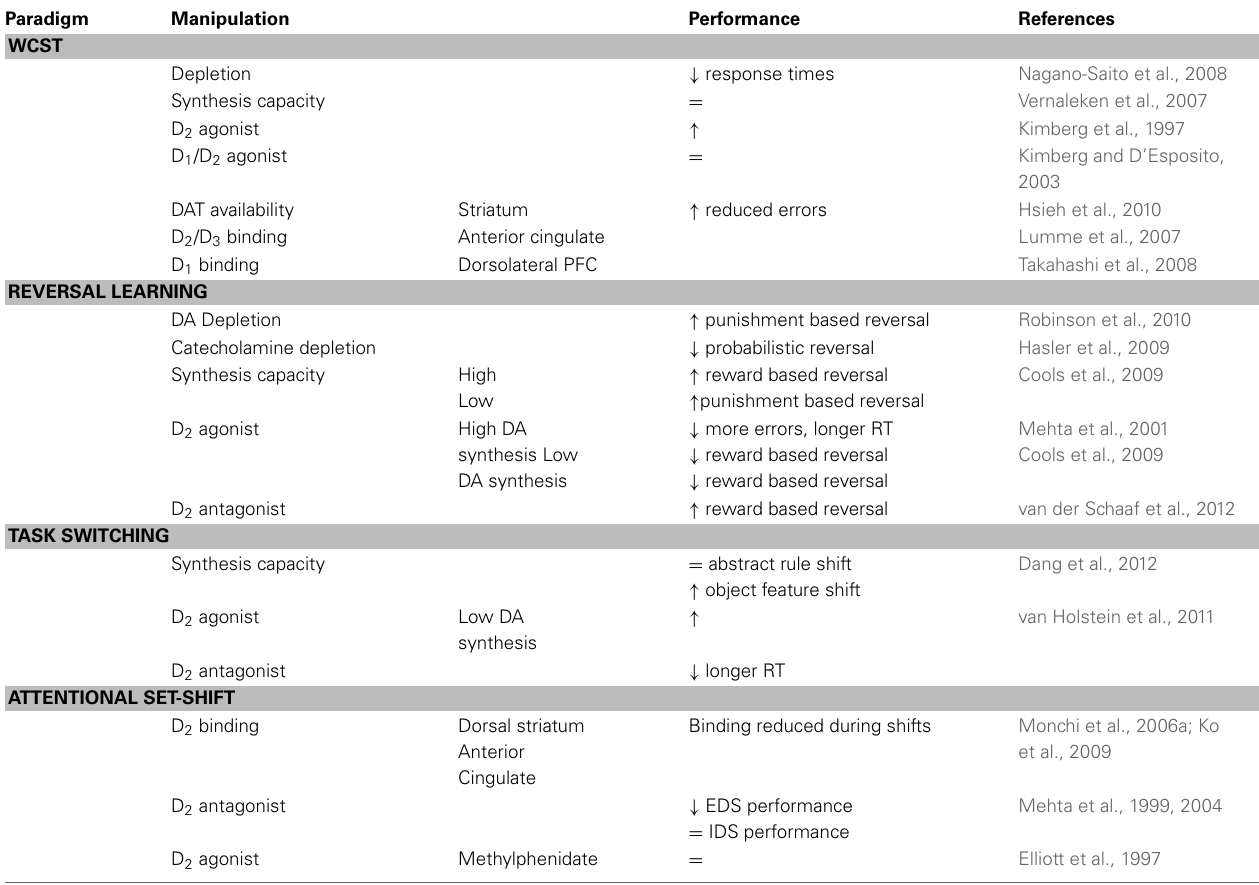
Table 1 | Summary of effects of pharmacological manipulations to the dopamine system on cognitive flexibility in human subjects.